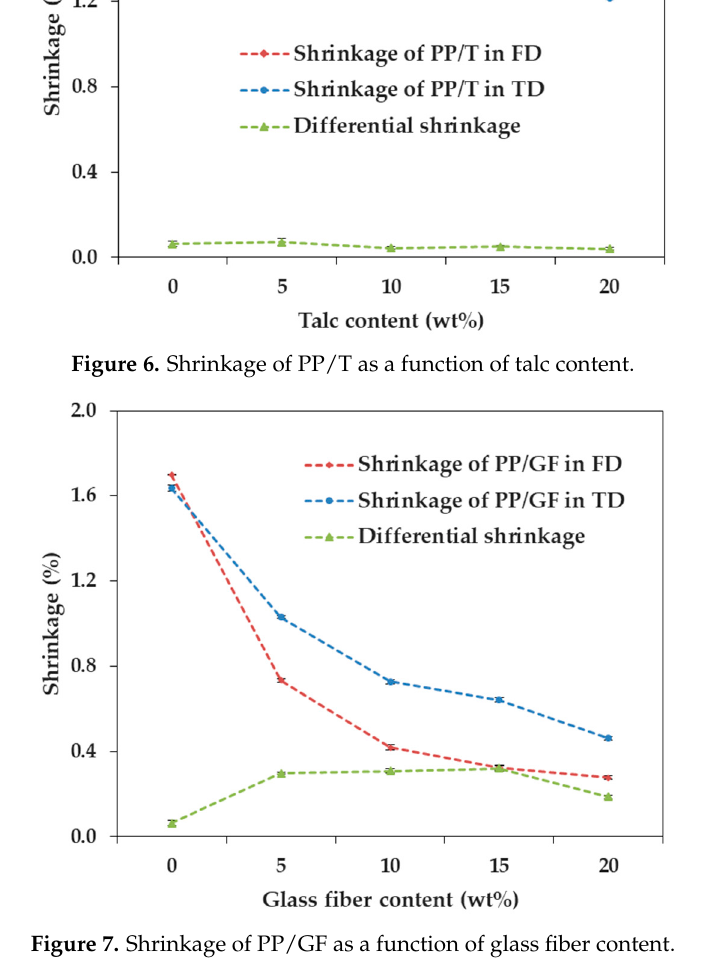
Figure 7. Shrinkage of PP/GF as a function of glass fiber content.